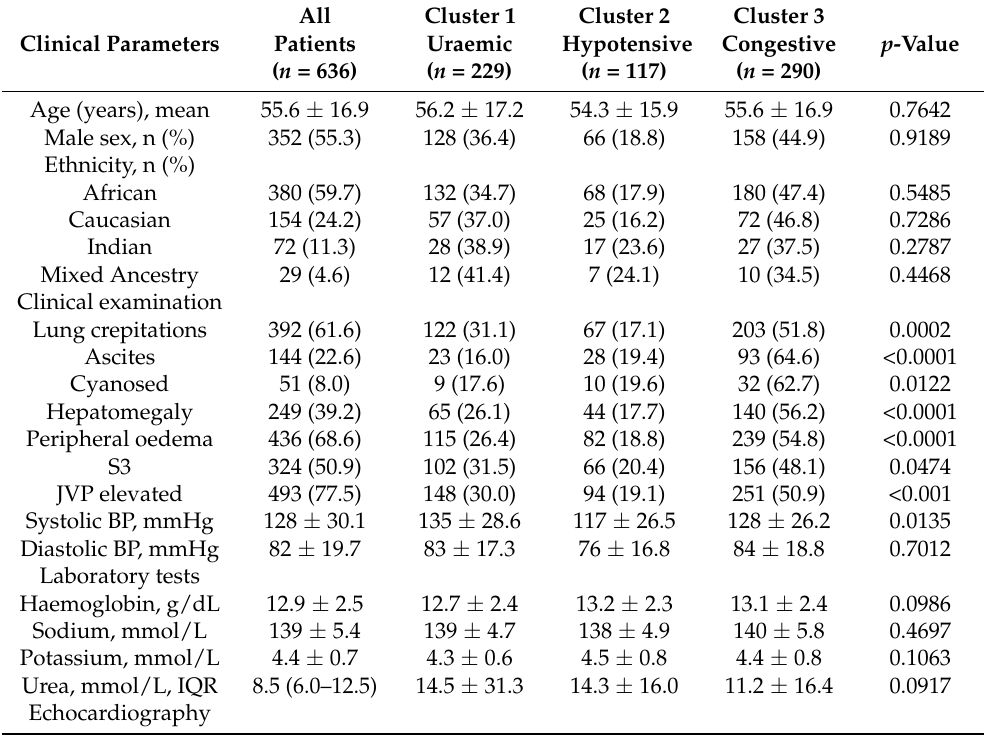
Table 3. Baseline demographic and clinical characteristics of the study patients stratified according to